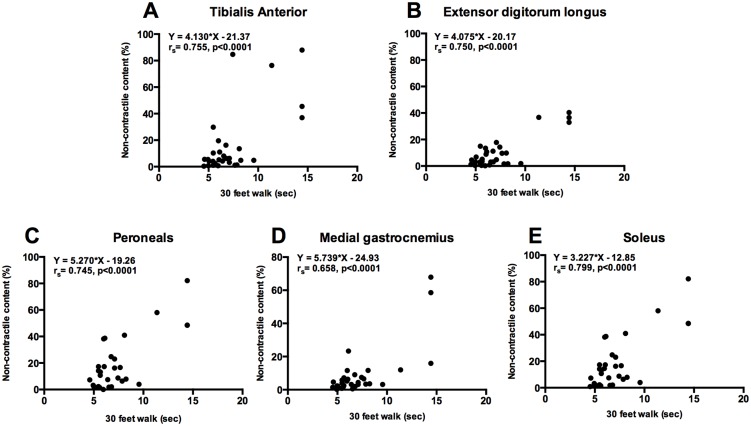
Relationship between NCC of different leg muscles and 30 feet walk (sec).There was a significant relationship between increase in NCC of all leg muscles and time taken to cover 30 feet distance (rs; 0.65–0.80, p<0.0001).